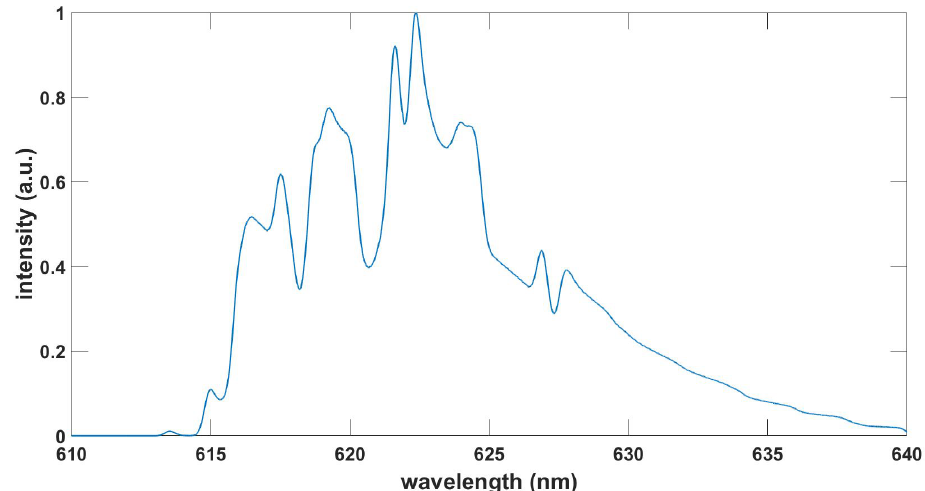
Figure 9. Computed TiO γ (cid:48) spectrum, ∆ v = 0, δ λ = 0.40nm, T = 3.6